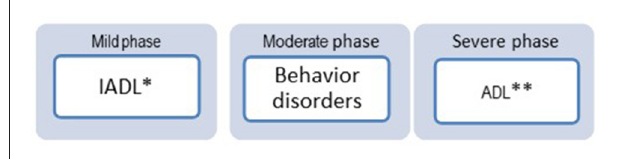
FIGURE 1 | Dependencies associated with the evolution stages of Ferretti (2020). *IADL, Instrumental activities daily living; **, ADL, activities daily